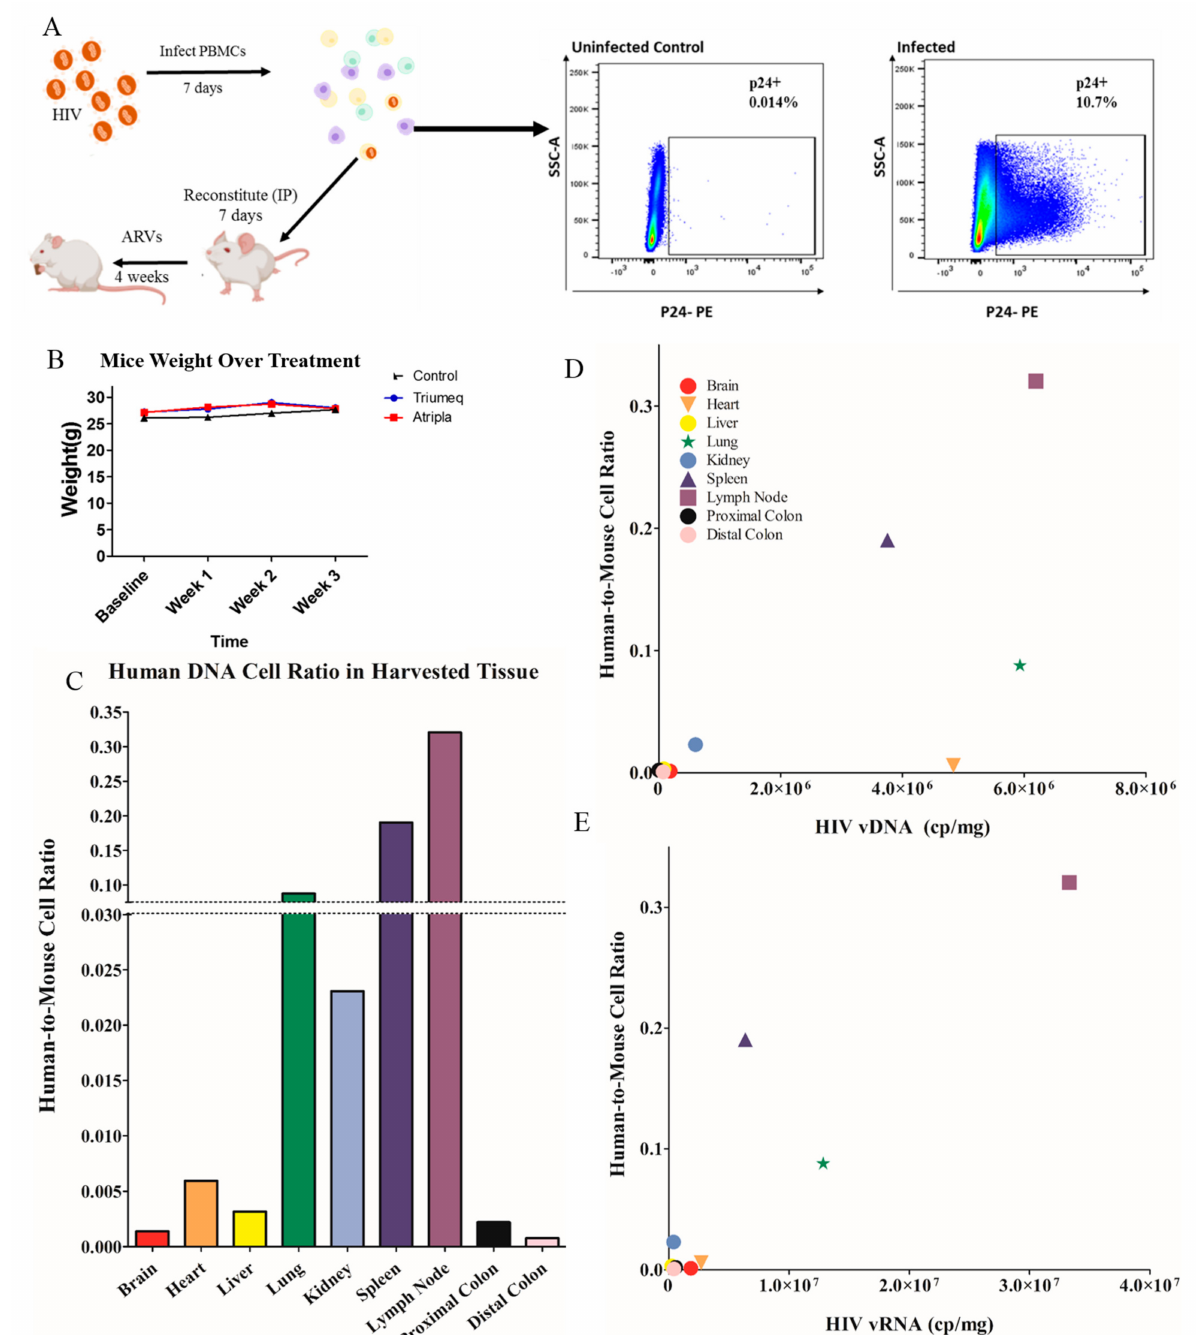
Figure 1. Human PBMCs trafficking to the peripheral tissues correlates with viral burden. ( A ) Im- munocompromised mice were reconstituted with PBMCs that had been infected with HIV for 7 days, prior to commencement of ARV therapeutic. The animal weight did not differ between the groups over the treatment time ( B ). In order to determine if the human cell trafficking was associated with the viral load in the peripheral tissue, the human DNA was quantified and expressed as a cell ratio of mouse DNA within each tissue type, providing relative human DNA content in every tissue ( C ). This was then correlated with ( D ) the viral DNA and ( E ) the viral RNA to determine if the human cell trafficking correlates with the viral